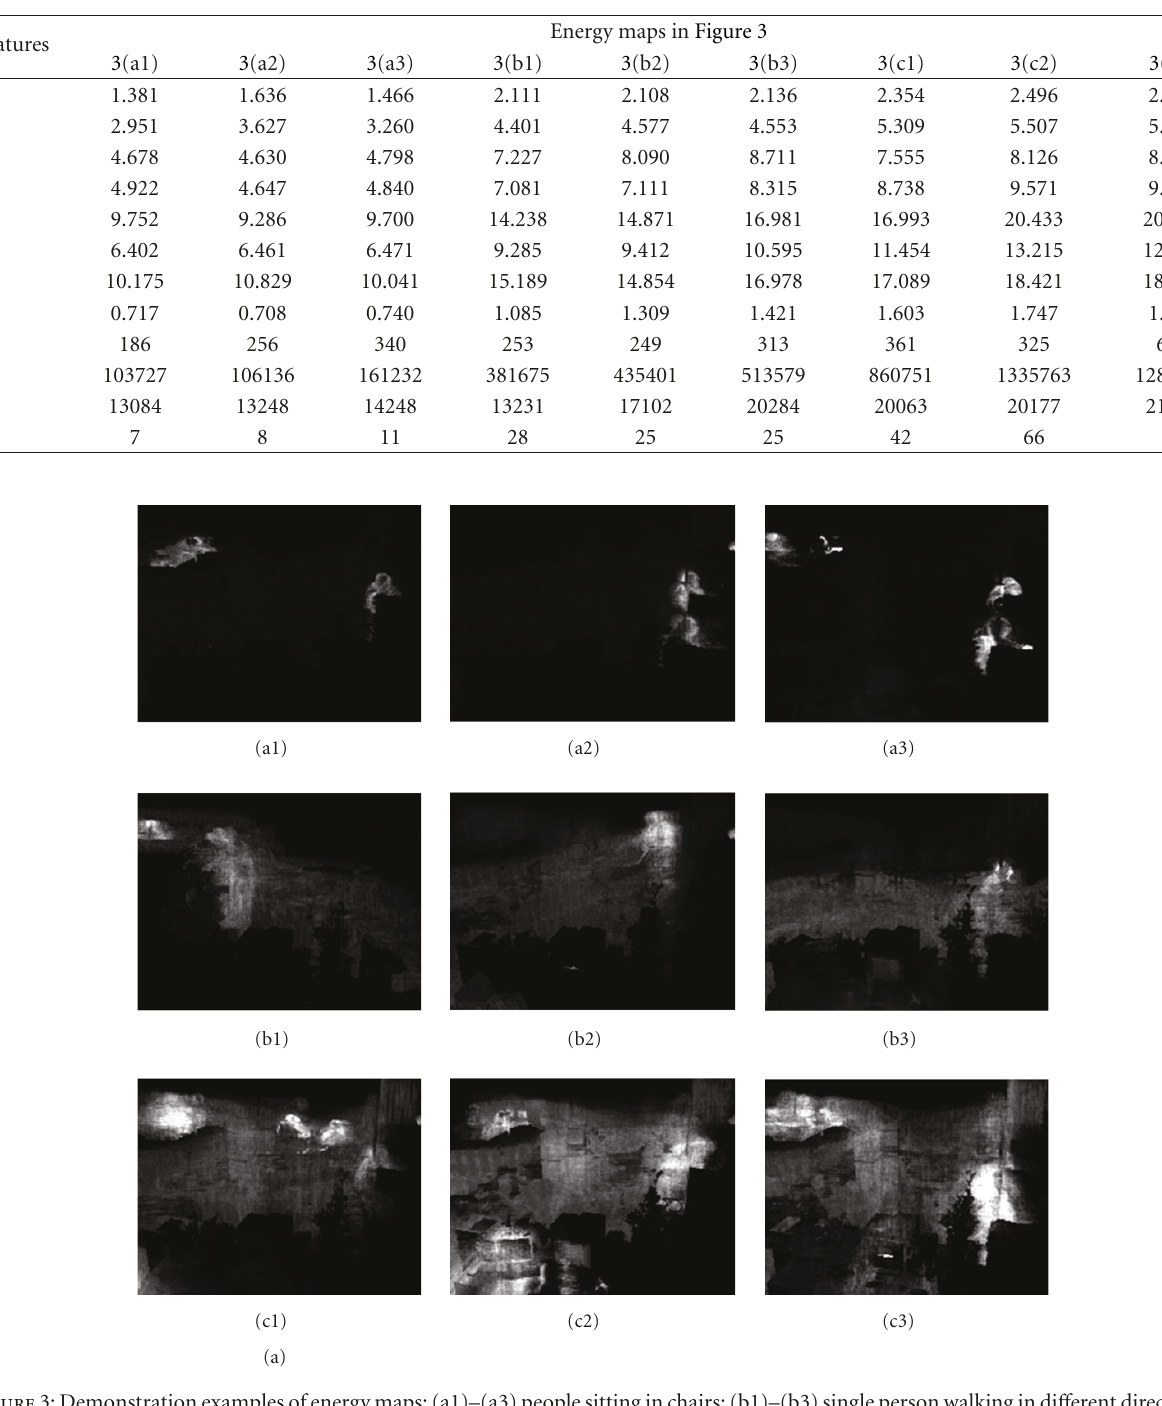
Table 1: Feature values for the demonstrative energy maps in Figure 3.